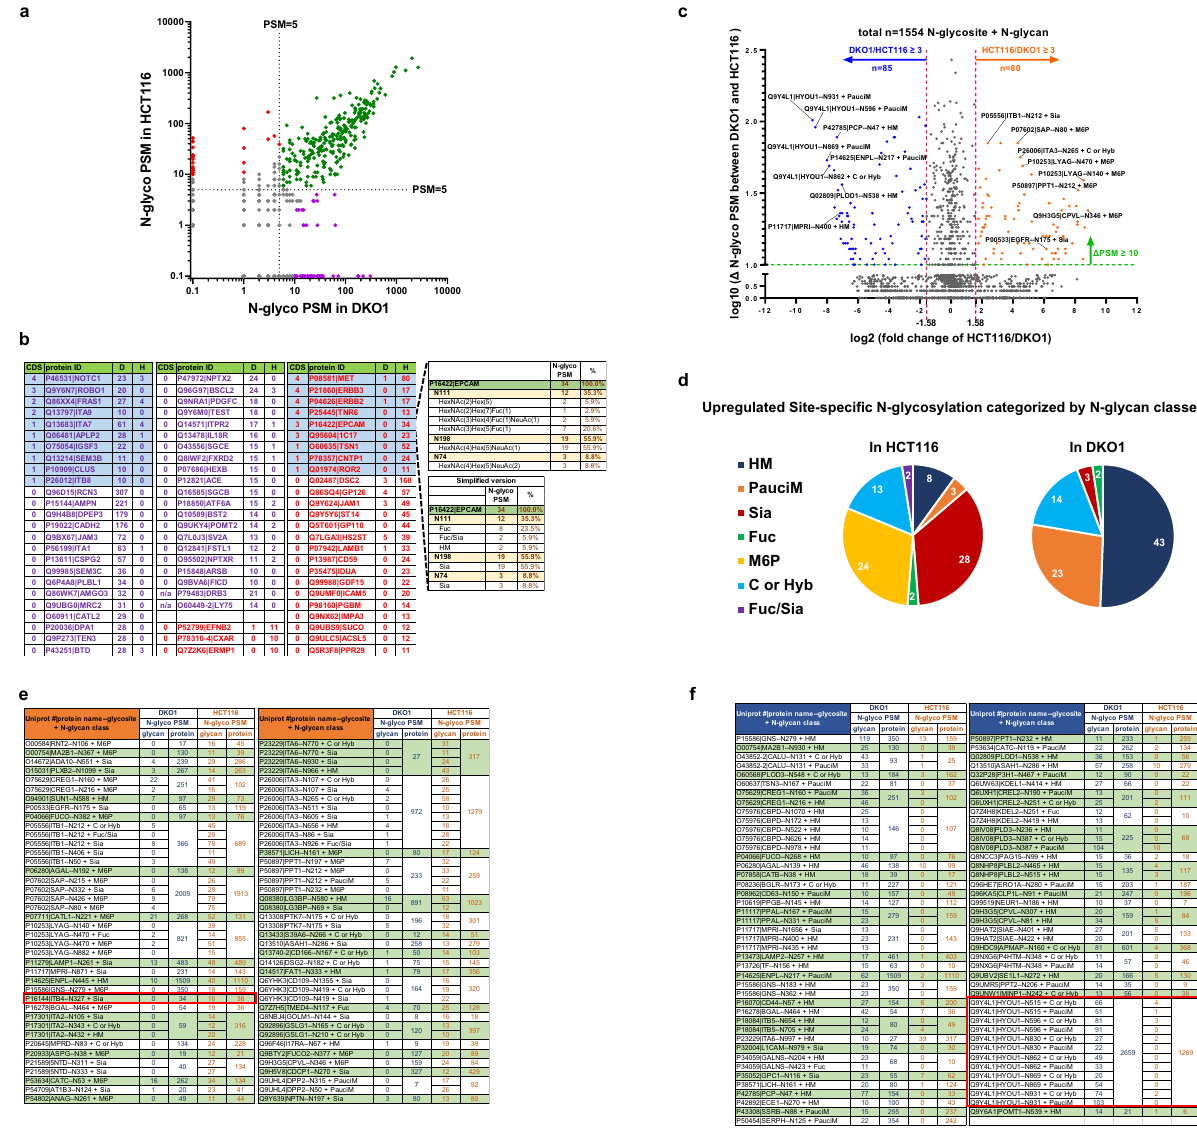
Fig. 3 Comparative analysis of site-speci fi c N-glycosylation between HCT116 and DKO1 cells. a Scatter plot to divide all the detected N-glycoproteins into 4 groups based on the N-glyco PSM numbers in HCT116 cells (y-axis) and DKO1 cells ( x -axis). The dotted line is a mark of N-glyco PSM = 5. Green dots represent a group of proteins with N-glyco PSM > 5 in both DKO1 and HCT116 cells. The rest of proteins with N-glyco PSM ≤ 5 in one of the cell lines are further divided into three groups. Red dots represent HCT116-speci fi c proteins where N-glycosylation is at least fi ve times greater in HCT116 cells than in DKO1 cells; purple dots represent DKO1-speci fi c proteins where N-glycosylation in DKO1 is at least fi ve times greater than in HCT116 cells; gray dots represent the proteins with N-glycosylation ratio between HCT116 and DKO1 < 5. b The N-glyco PSM in HCT116 (H) and DKO1 (D) of the proteins represented by red dots and purple dots (in a ) are listed. Cancer driver score (CDS) of the corresponding genes is also evaluated. The proteins with CDS ≥ 1 are highlighted in blue. The site-speci fi c N-glycosylation of P16422| EPCAM is presented as an example in these two groups. c Volcano plot to show the comparative analysis of site-speci fi c N-glycosylation of the proteins with N-glyco PSM > 5 in both HCT116 and DKO1 cells (green dots in a ). A total of 1554 site-speci fi c N-glycosylation data points are plotted according to log2 (the fold change of HCT116/DKO1) in x -axis and log10 (the difference of N-glyco PSM between DKO1 and HCT116) in y -axis. The orange and blue dots indicate the upregulated ( ≥ 3-fold increase and ≥ 10 N-glyco PSM difference) site-speci fi c N-glycosylation in HCT116 and DKO1 cells, respectively. The identities of 8 orange or blue dots are indicated as examples. Detailed calculations can be found in Supplemental Data 6, Red tab. d Pie charts to categorize by N-glycan classes the upregulated site-speci fi c N-glycosylation in HCT116 and DKO1 cells. The numbers within the pie charts indicate the numbers of upregulated site-speci fi c N-glycosylation in the respective N-glycan class. e , f list the detailed information of the upregulated site-speci fi c N-glycosylation in HCT116 cells (orange dots in c ) and DKO1 cells (blue dots in c ), respectively. Searchable tables can be found in Supplemental Data 6, Orange tab or Blue